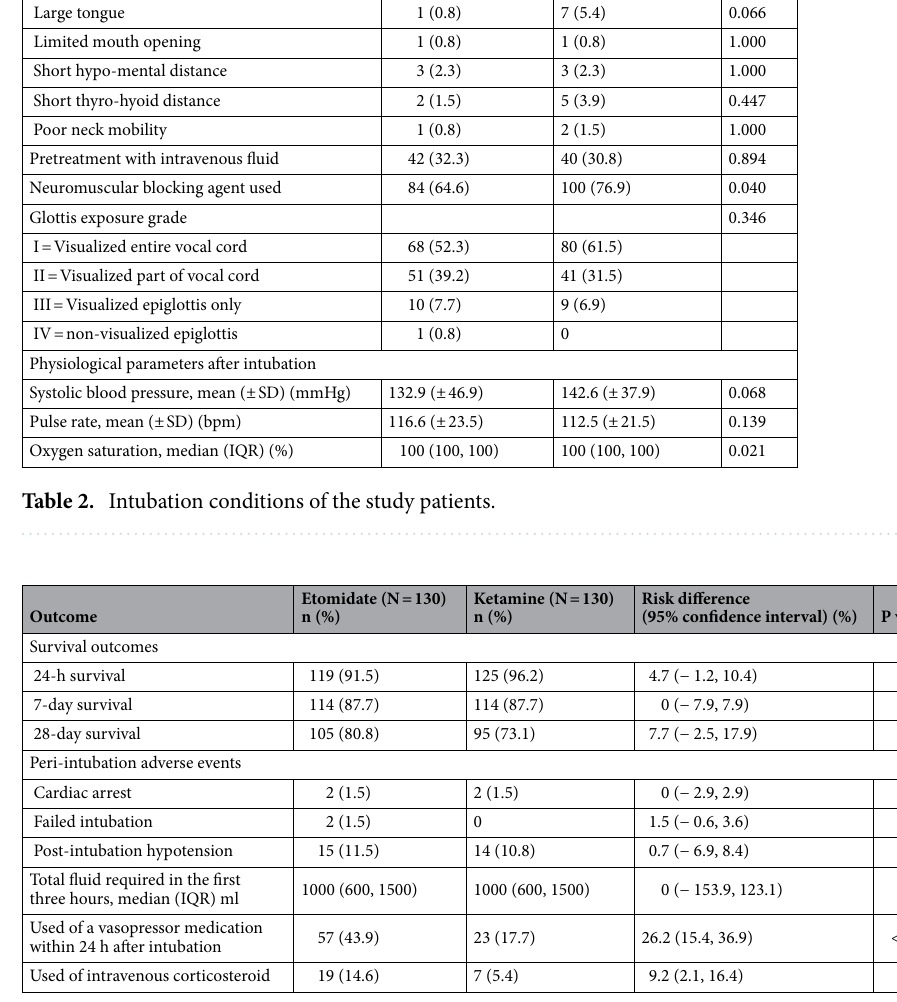
Table 3. Primary and secondary